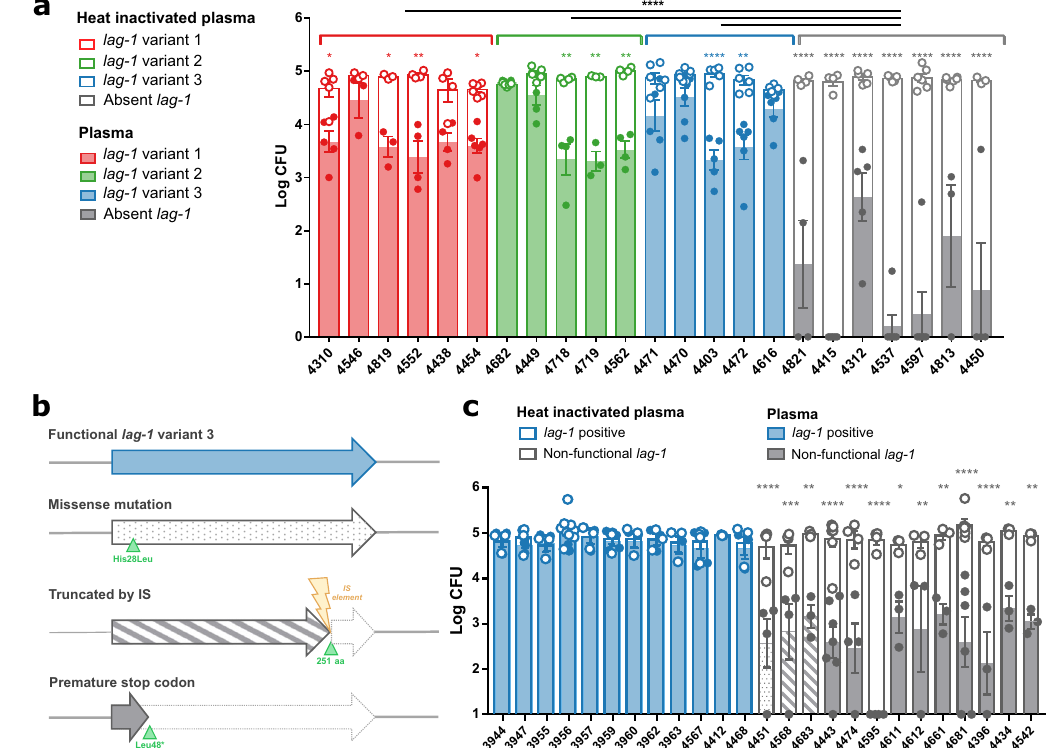
Fig. 4 Presence of functional lag-1 correlates with resistance to killing in human plasma. a Representative L. pneumophila isolates containing allelic variants 1, 2, and 3 of lag-1 (depicted in red, green, and blue, respectively) or lag-1 -negative (depicted in grey) were incubated with human plasma (coloured bars and dots) or heat-inactivated plasma (open bars and dots) for 1 h at 37 °C. Each dot represents an average cfu count in plasma from a single donor ( n = 7 donors for strain 4470, n = 6 for strains 4454, 4471, 4472, 4616, 4537, 4597; n = 5 for strains 4310, 4682, 4449, 4403, 4415, 4312; n = 4 for strains 4552, 4438, 4718, 4562, 4821, 4450 and n = 3 for strains 4546, 4819, 4719, 4813). Mean + / − SEM, One-way Anova with Holm-Sidak ’ s multiple comparisons test between Plasma and Heat-inactivated plasma for the same strain. One-way Anova with Tukey ’ s multiple comparisons test for differences between the variants. * p < 0.05, ** p < 0.01, **** p < 0.0001. Source data and exact p -values are provided in the Source Data fi le. b Schematic representation of the multiple natural lag-1 independent deactivating mutations in epidemiologically-related isolates. In blue — functional lag-1 , with dots — lag-1 with His28Leu mutation, with lines — lag-1 truncated by an insertion sequence in aa 251, in grey — lag-1 truncated by a premature stop codon. c Isolates with lag-1 mutations show increased susceptibility to killing in human plasma. Closely related isolates from the same hospital-associated cluster were incubated with human plasma (coloured and patterned bars and dots) or heat-inactivated plasma (open bars and dots) for 1 h at 37 °C. Each dot represent an average cfu count in plasma from a single donor ( n = 9 donors for strain 3956; n = 7 for strain 4443; n = 6 for strain 4681; n = 4 for strains 3947, 3959, 4567, 4451, 4474, 4568, 4595 and n = 3 for all other strains). Mean + / − SEM, One-way Anova with Holm-Sidak ’ s multiple comparisons test between Plasma and Heat-inactivated plasma for the same strain, * p < 0.05, ** p < 0.01, **** p < 0.0001. Source data and exact p -values are provided in the Source Data fi